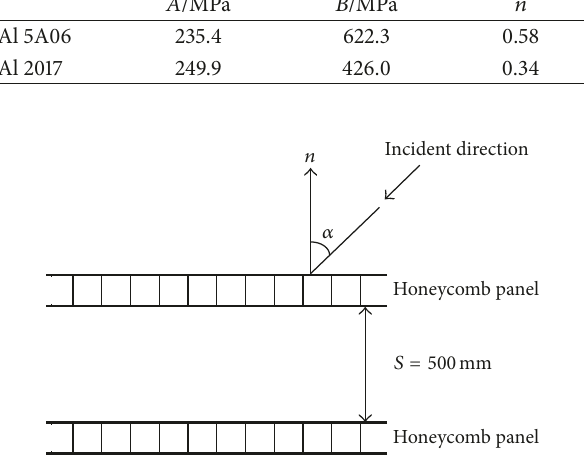
Figure 1: Double honeycomb sandwich panel structure diagram.